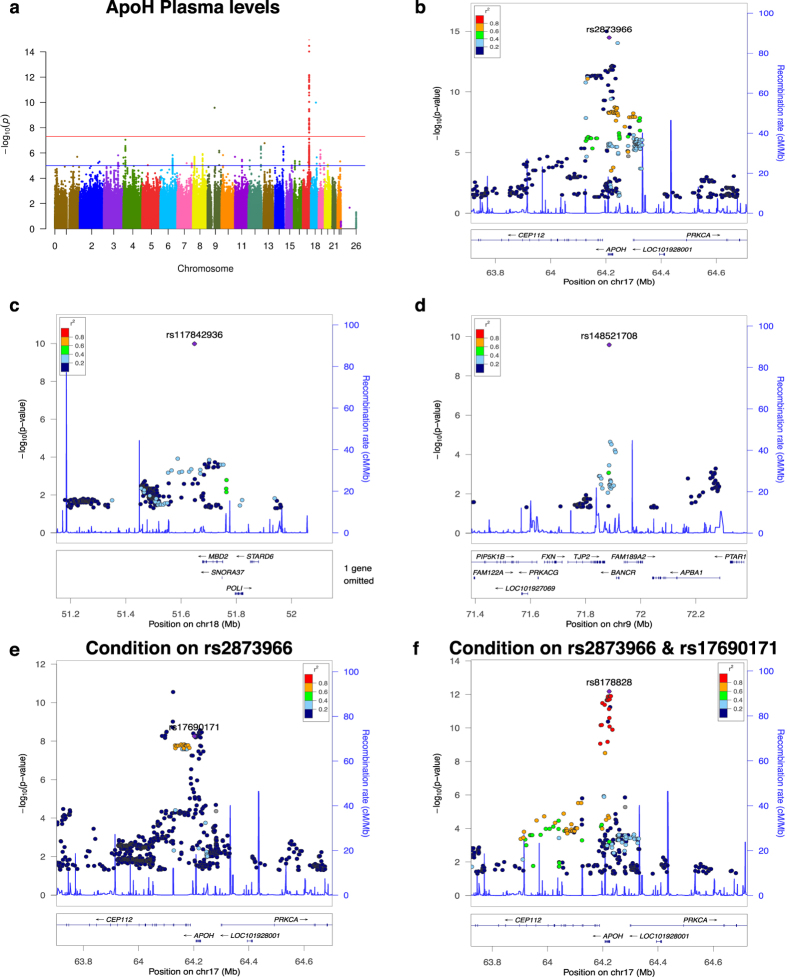
Manhattan and regional plots for associations with plasma levels of ApoH.(a) Manhattan plot of −log10 p-values for association with plasma levels of ApoH levels; (b) Regional plot for genome-wide significant association on chromosome 17 with ApoH plasma levels; (c) Regional plot for genome-wide significant association on chromosome 18 with ApoH plasma levels; (d) Regional plot for genome-wide significant association on chromosome 9 with ApoH plasma levels; (e) Regional plot for genome-wide significant association on chromosome 17 after conditioning for rs2873966; (f) Regional plot for genome-wide significant association on chromosome 17 after conditioning for rs2873966 and rs17690171.